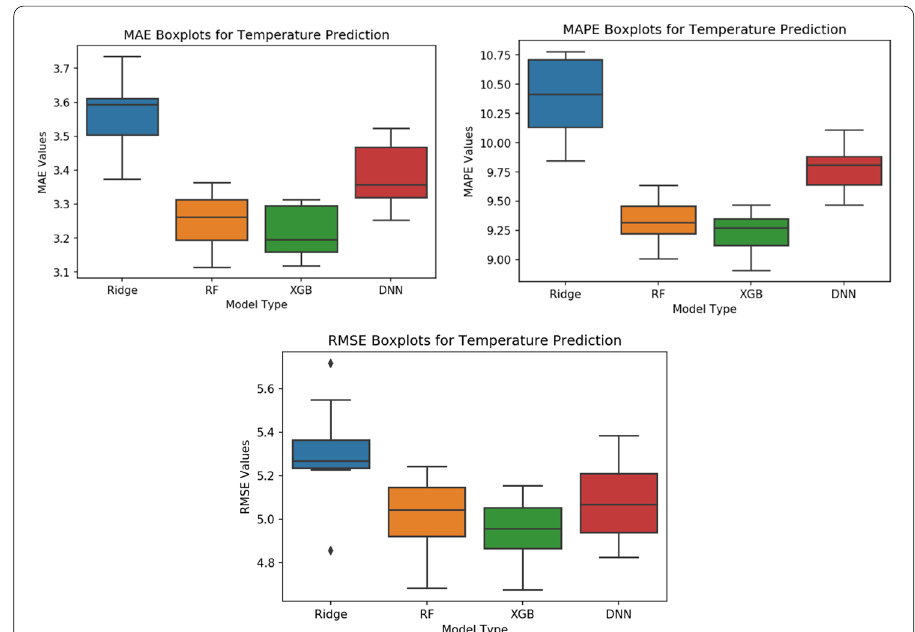
Fig. 6 Accuracy comparison between four machine learning models